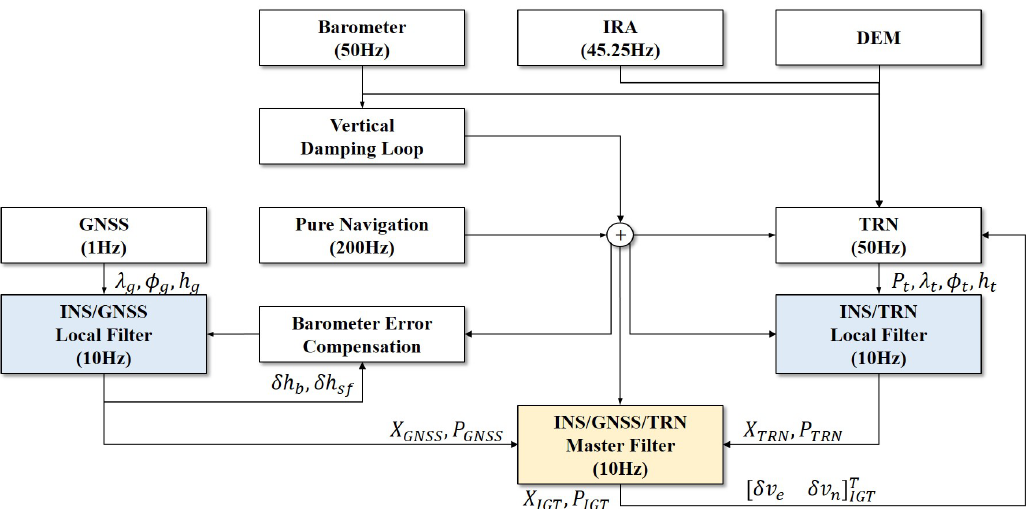
Figure 2. Block diagram of federated filter-based inertial navigation system (INS)/global navigation satellite system (GNSS)/terrain referenced navigation (TRN) integrated